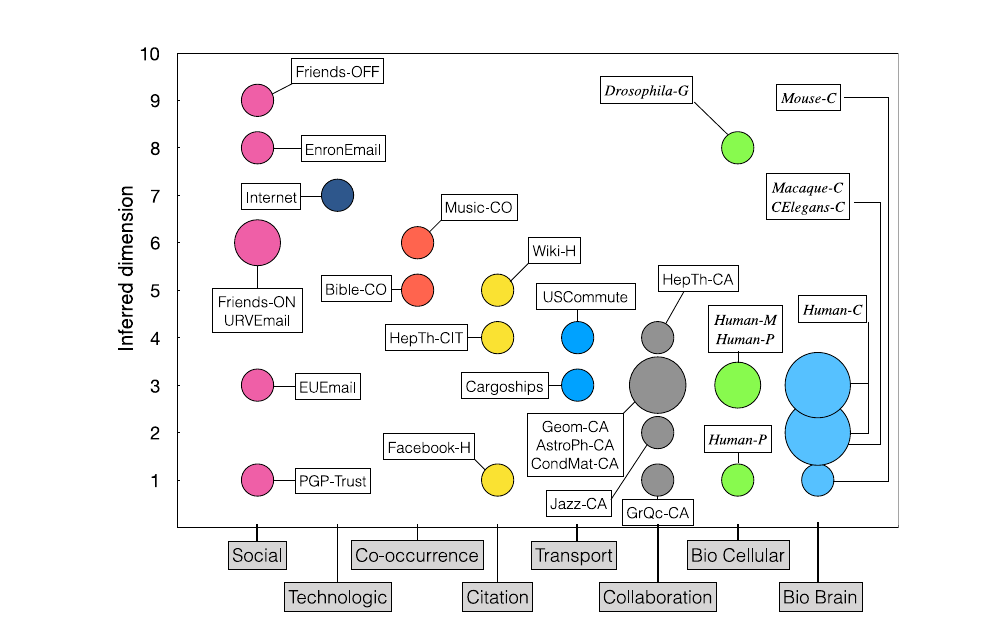
Fig. 4 | Estimationofthedimensionofreal networks. Meandensities of edge triangles, squares, and pentagons forthe Internet atthe autonomous system level( A – C ), the email network within the Enron company ( D – F ), and a human connectome ( G – I